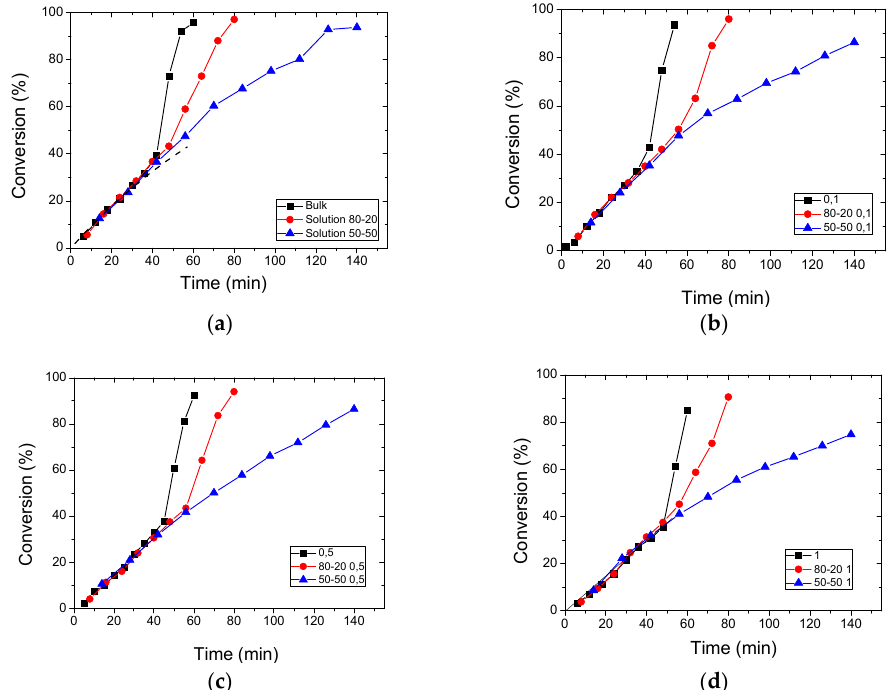
Figure 3. Conversion versus time curves of neat PMMA obtained after bulk and solution polymerization ( a ); PMMA/GO nanocomposites with different relative amounts of GO obtained from in situ bulk polymerization at 80 °C with a 0.03 mol/L initial initiator concentration, 0.1 % ( b ); 0.5% ( c ); 1.0% ( d ).